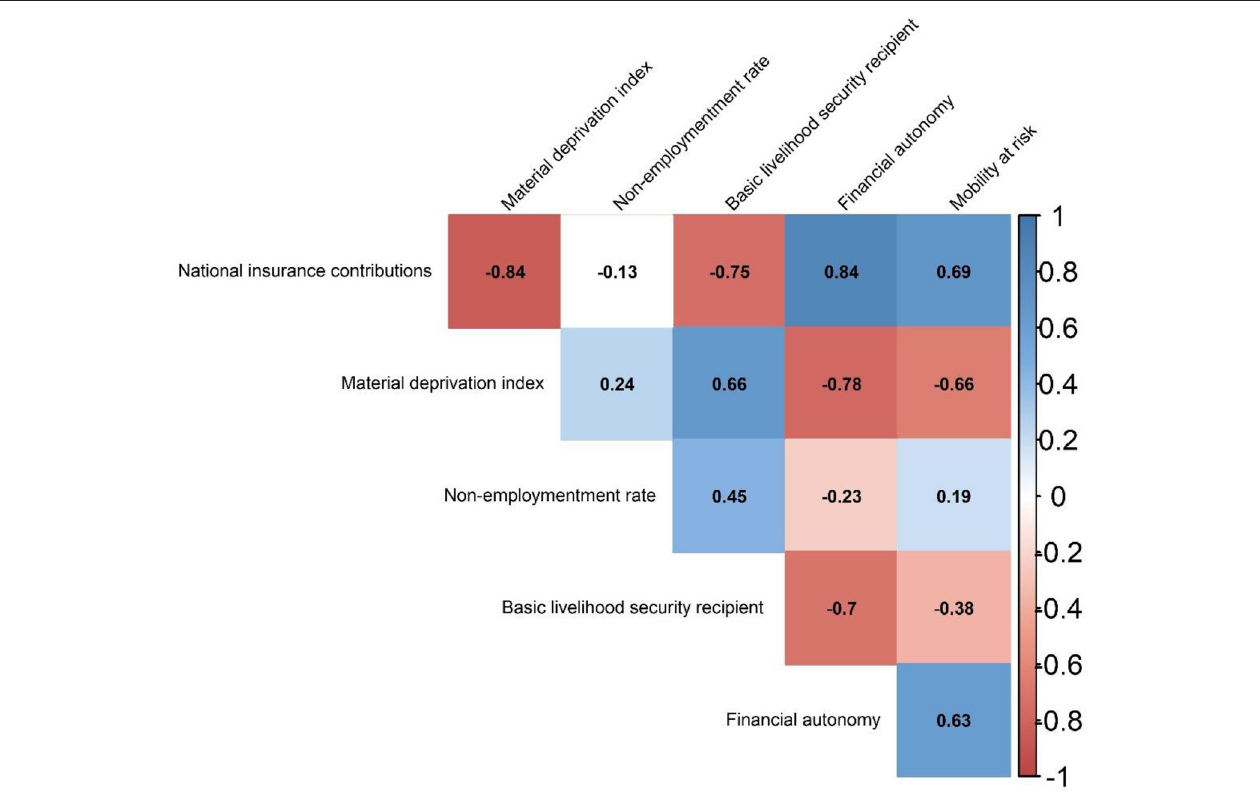
FIGURE 3 | Correlation plot between socioeconomic status and economic activity variables. The number inside the cell corresponded to Spearman correlation coefficient estimates. The intensity of correlation was expressed by colored gradient where dark blue represented one (a complete positive correlation) and dark red represented minus one (a complete negative correlation). All correlation coefficients estimates were statistically significant ( p < 0.05).